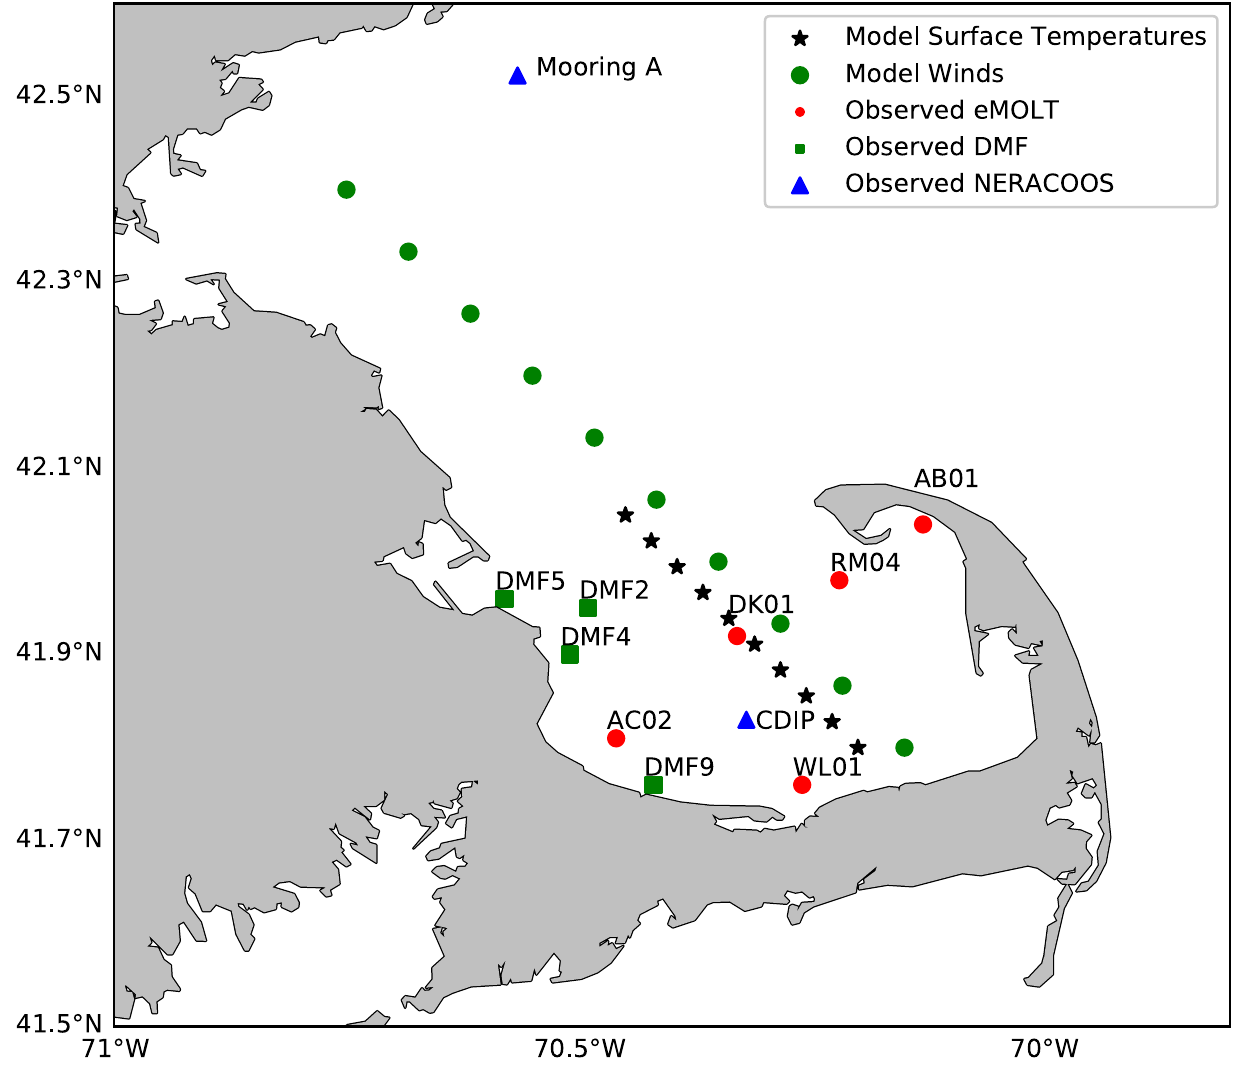
Fig 2. Locations of moored observations used in this report including two NERACOOS moorings (blue triangles), five eMOLT moorings (red circles) and four Massachusetts Division of Marine of Fisheries moorings (green squares). Also posted are the positions where wind and surface temperature were extracted from the